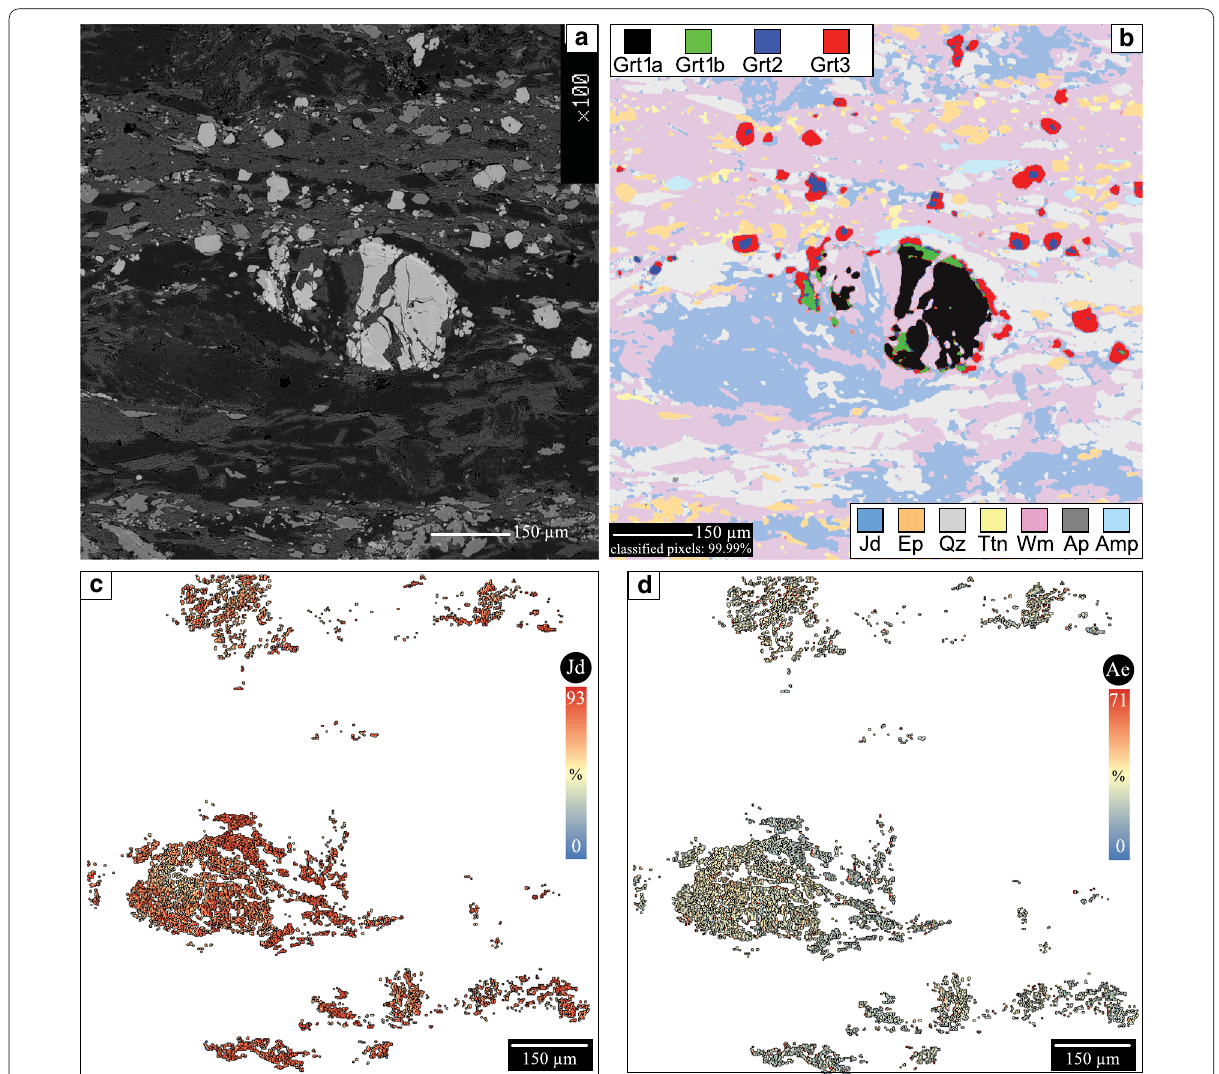
Fig. 7 Results of Q-XRMA second and third cycle for garnet-bearing gneiss (ZR4-C7 microdomain). a Back-Scattered Electron (BSE) image of Fig. 4d, rotated of 90 degree. b Result of second cycle showing Grt generations classification and mineral classification of X-ray map. Four generations for garnet can be detected. Grt1a is the porphyroclast, Grt1b rims Grt1a and fills microfractures within the Grt1a, Grt2 occurs at the rim of Grt1 and at the core of garnets syn-kinematic with the S2 mylonitic foliation and Grt3 is the corona of Grt2. The amount of pixels classified is 99.99%. Result of third cycle showing ( c ) jadeite (Jd) and aegirine ( d ) component (Ae) map for all Cpx of the X-ray map. Aeg exsolutions are very small and cannot be observed on the BSE image